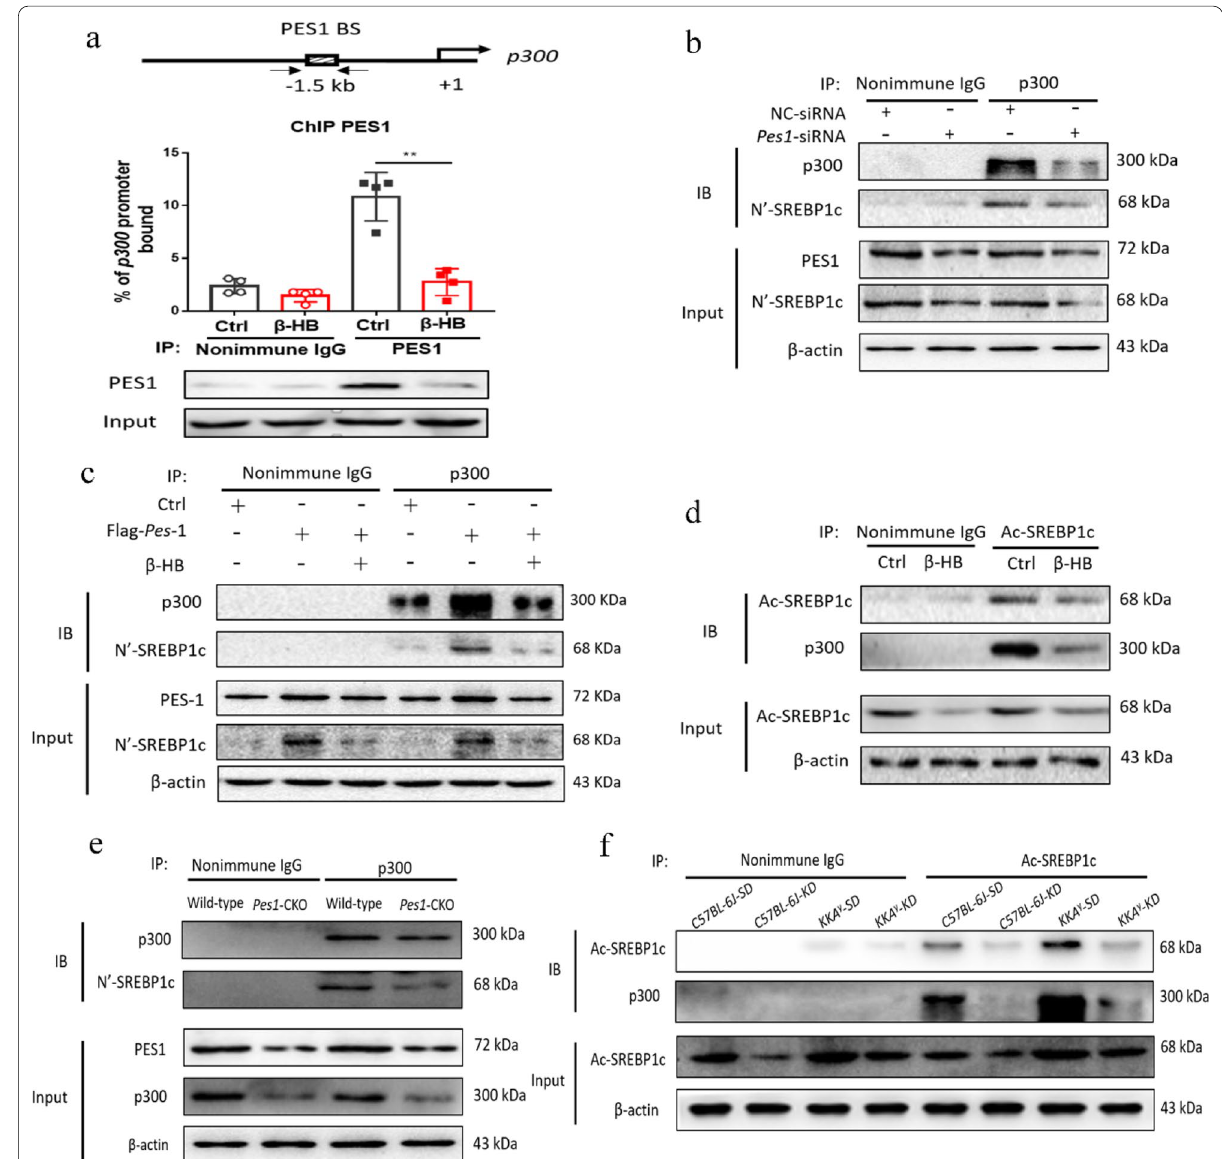
Fig. 6 β-HB reduced PES1 binding to the p300 promoter and downregulated PES-1 mediated acetylation of SREBP1c. a β-HB decreased PES1 binding to the p300 promoter. b , c PES1 knockdown or overexpression inhibited or enhanced the interaction between p300 and SREBP1c in hepatocytes. d β-HB treatment decreased the acetylation of SREBP1c in hepatocytes. e Pes1 knockout impaired the interaction between p300 and SREBP1c in mice. f KD feeding decreased the acetylation of SREBP1c in normal and diabetic mice. Data were shown as mean experiment performed independently 3 times. *P < 0.05, **P < 0.01, ***P < 0.001 compared with control (ANOVA, Student–Newman–Keuls q